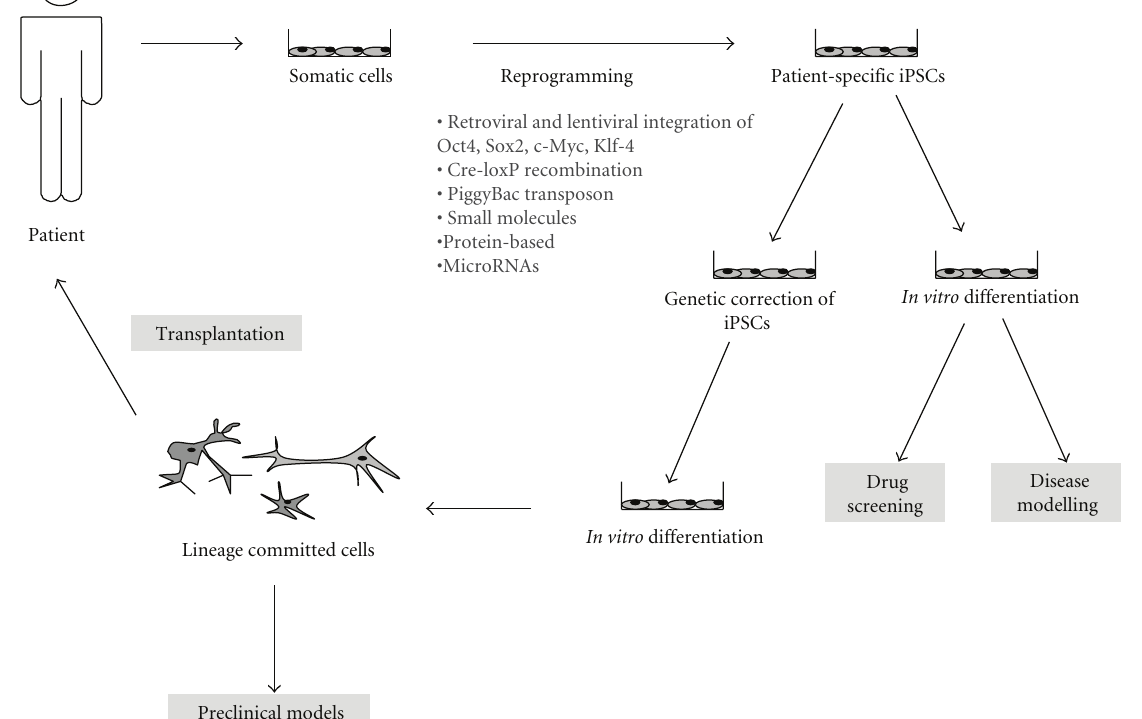
Figure 1: Potential applications of patient-specific pluripotent stem cells in neurological